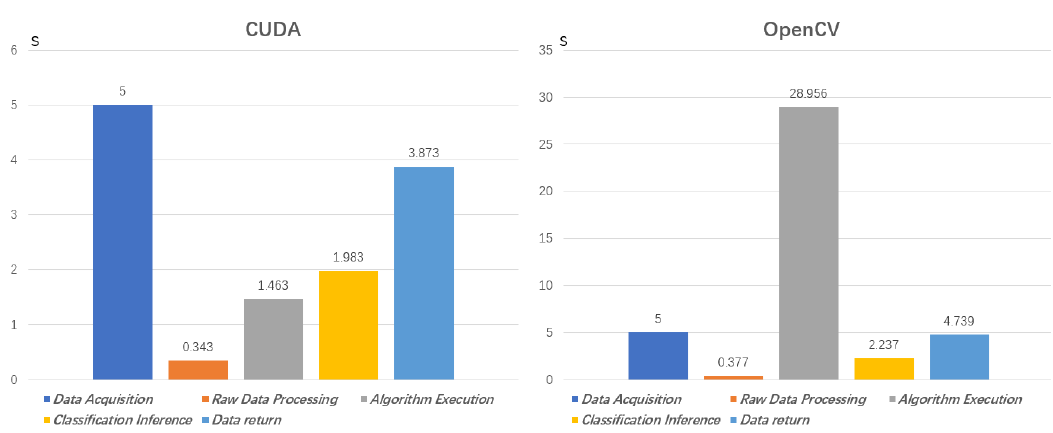
Figure 11. Time-consuming of several predominant operations of CUDA and OpenCV version in one shutter process.